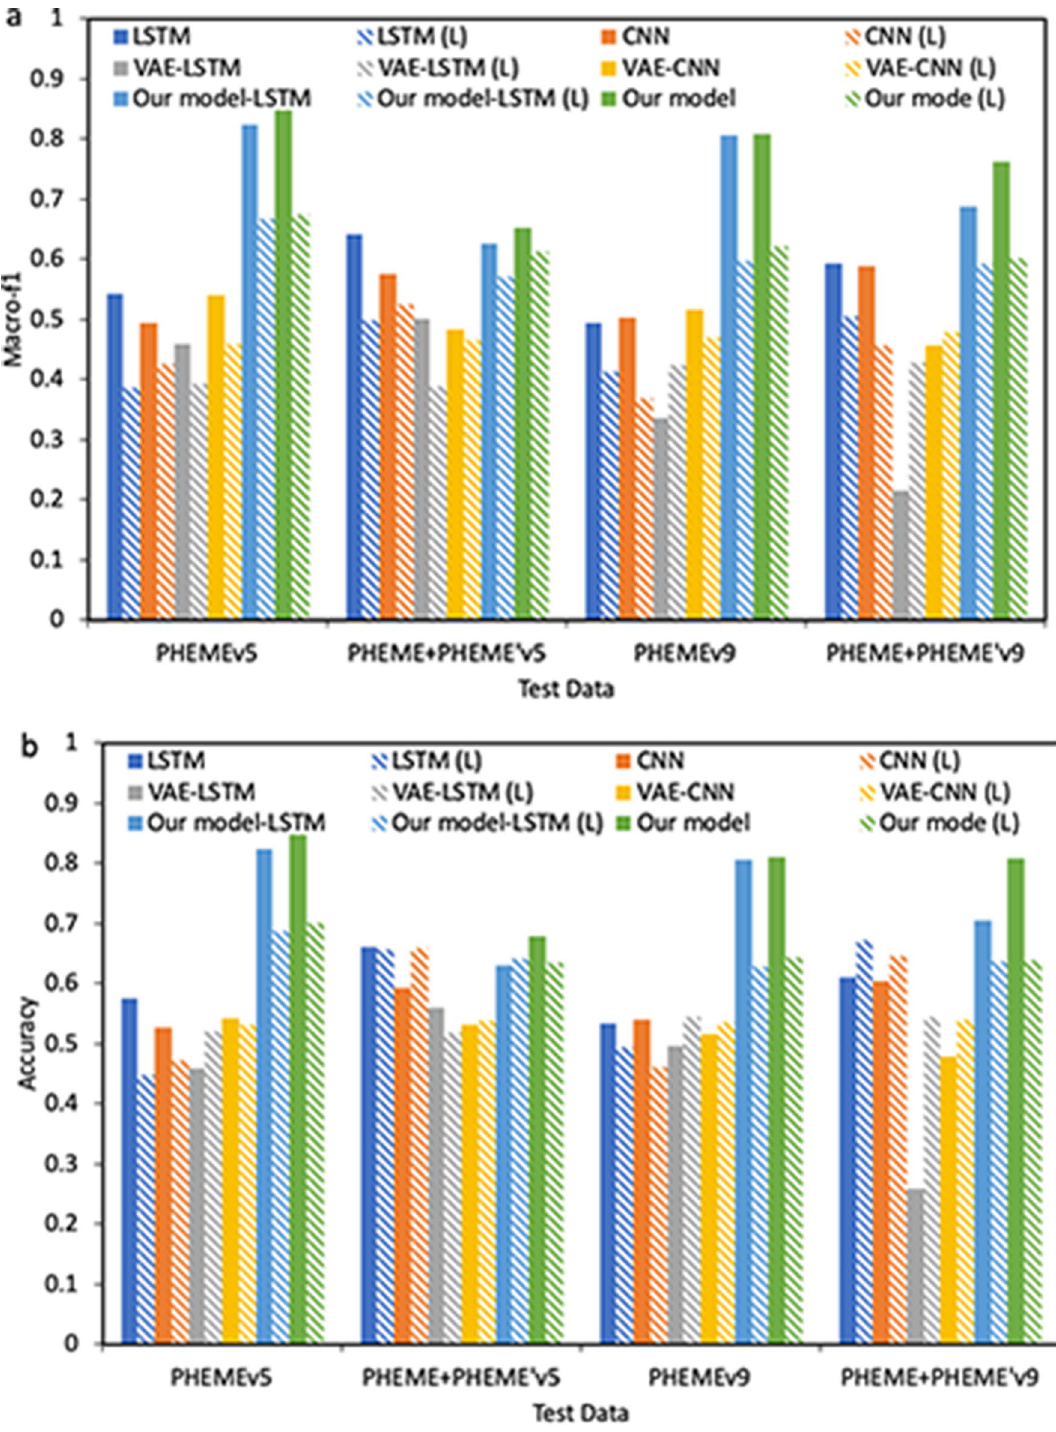
Figure 1. Macro-f1 ( a ) and accuracy ( b ) comparison between our model (-CNN and our model-LSTM) and baselines on the rumor detection task. The models are trained on augmented dataset PHEME+PHEME’ and tested on both original PHEME and augmented PHEME+PHEME’. L represents the model is evaluated under leave-one-out